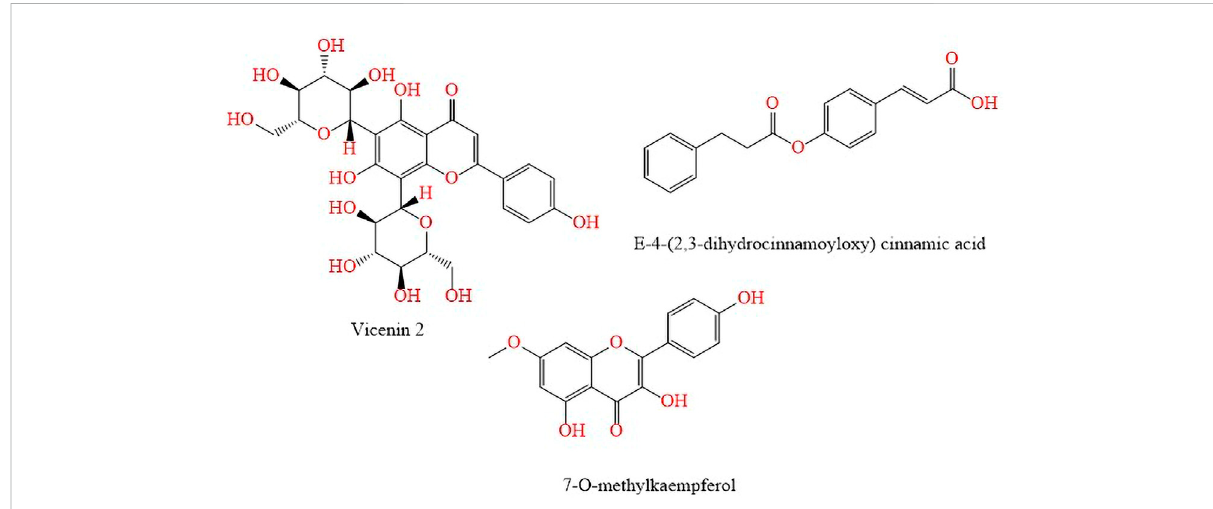
FIGURE 6 Flavonoids and phenolic acids found in the hydroalcoholic extract of B. dracunculifolia leaves and green propolis.